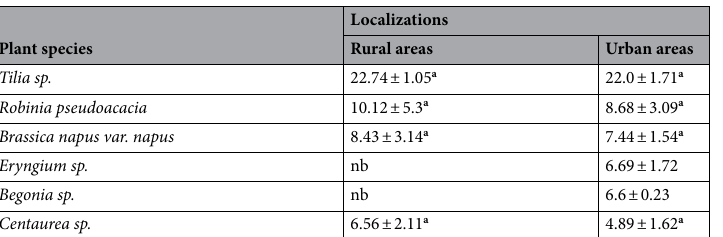
Table 1. The prevalence of the dominant pollen of several plant species. The pollen [mean ± SD] frequency from few species of plants in honey samples from urban and rural apiaries. Only a few dominant plant species (pollen frequency over 6%) are presented. Different letters—significant differences between pollen frequency in honey samples from two types of the apiary. Student t-test. p ≤ 0.05. nb not observed.